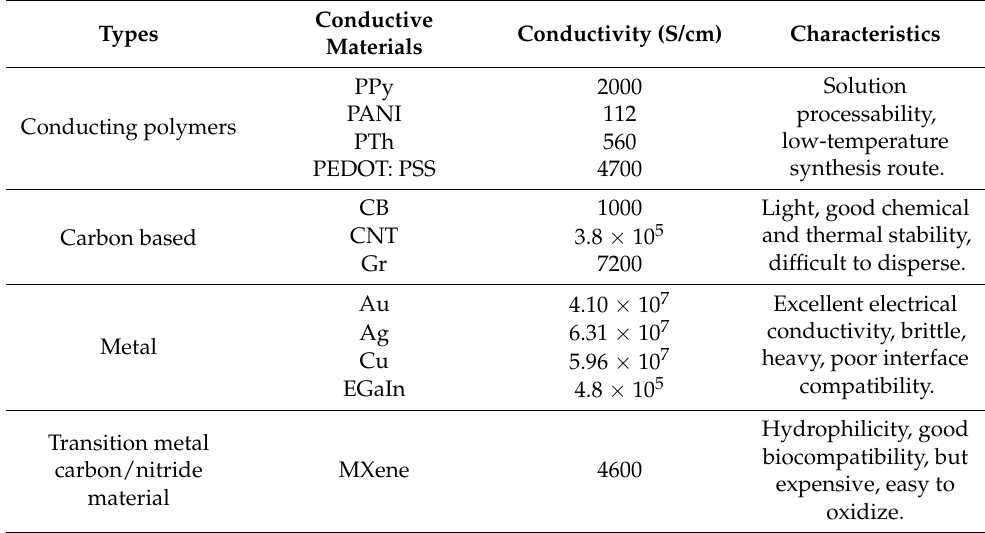
Table 3. Common conductive materials and their characteristics